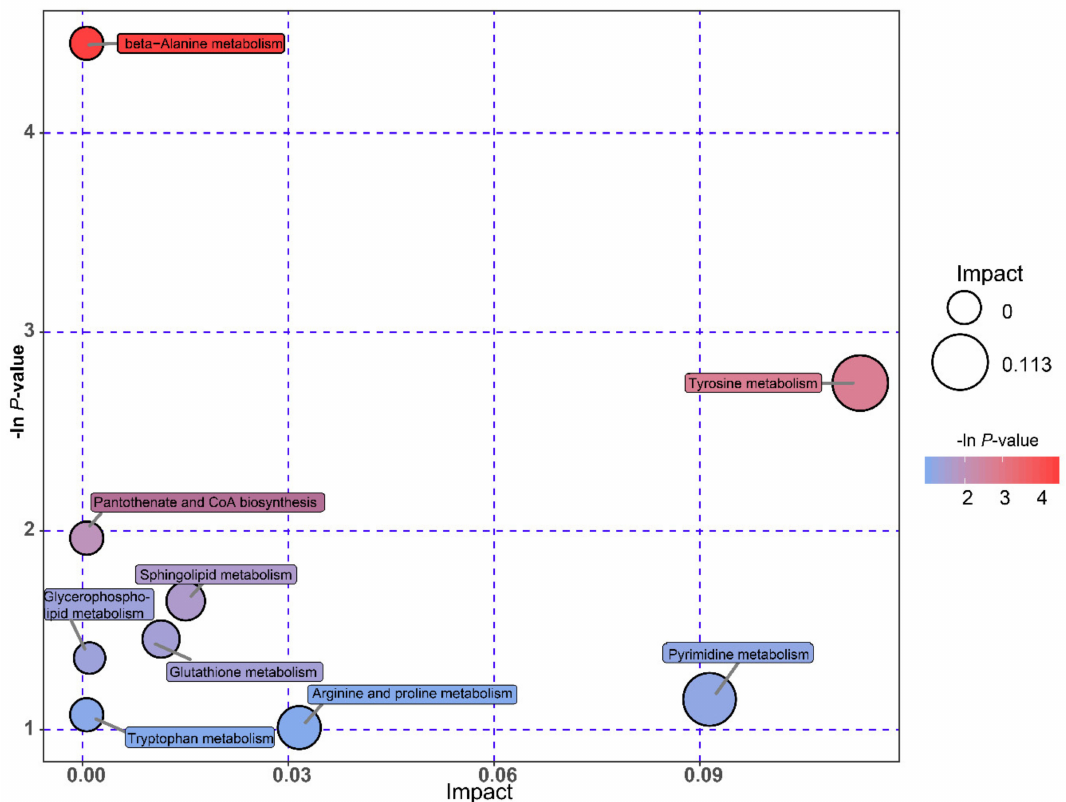
Figure 5. Metabolome view map of the deferential metabolites (VIP > 1, p < 0.05) identified in the rumen from the goats fed with the diets with di ff erent energy and protein levels. The large size indicates high pathway enrichment, and dark color indicates high pathway impact